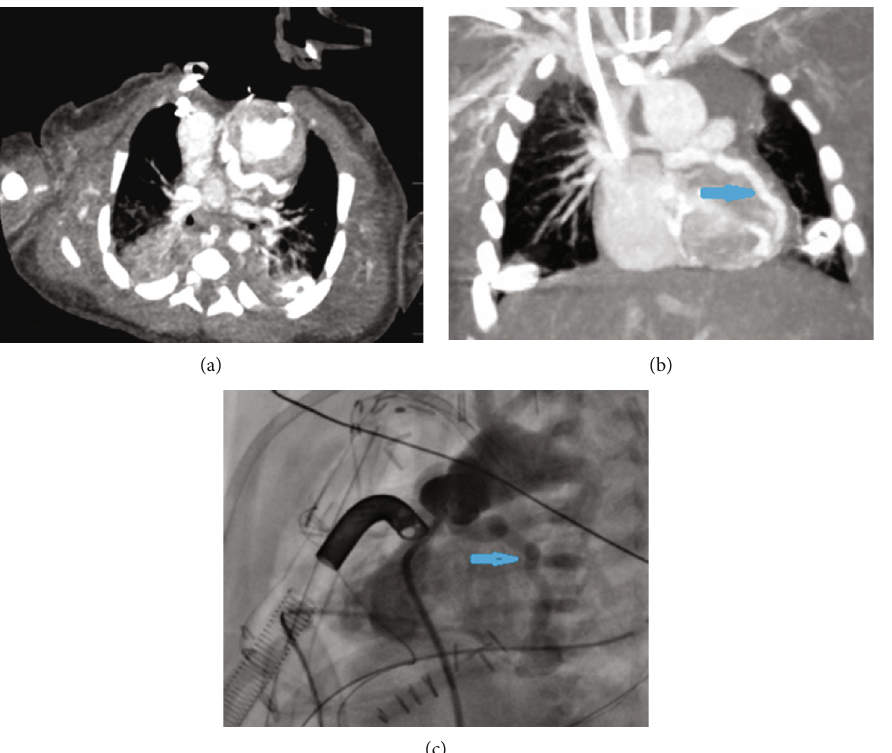
Figure 1: (a) Axial image of dilated left anterior descending artery. (b) Coronal image of ventriculocoronary fi stulas between the left anterior descending artery and the left ventricle (blue arrow). (c) Conventional angiography of ventriculocoronary fi stulas (blue